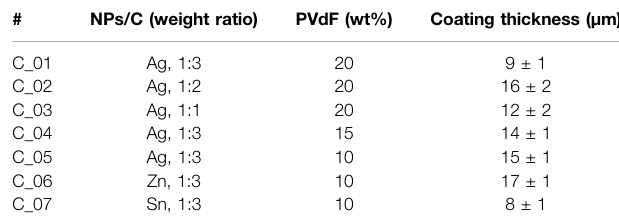
TABLE2| Listofdifferentcoatings